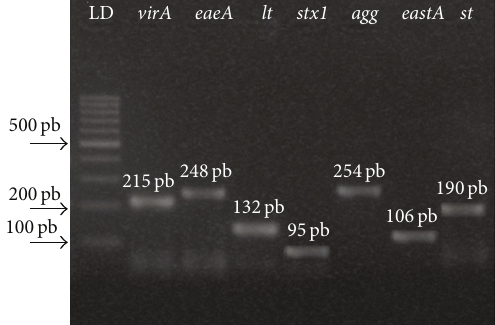
Figure 1: Specific amplicons of E. coli virulence genes. E. coli viru- lence gene ( virA ), enteroinvasive E. coli ( eaeA ), enteropathogenic E. coli ( lt and st ), enterotoxigenic E. coli ( stx1 ), enterohemorrhagic E. coli ( astA ), and enteroaggregative E. coli ( agg ).